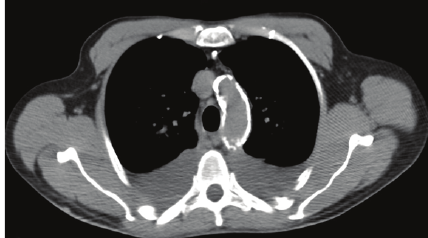
Figure 2: Chest computerized tomography, transverse